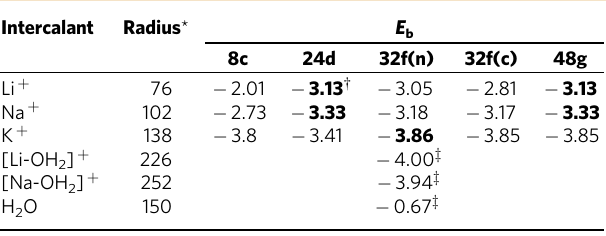
Table 1 | Radii (unit: pm) of intercalants and the calculated binding energies ( E b , unit: eV) when intercalant occupying different interstitial sites.